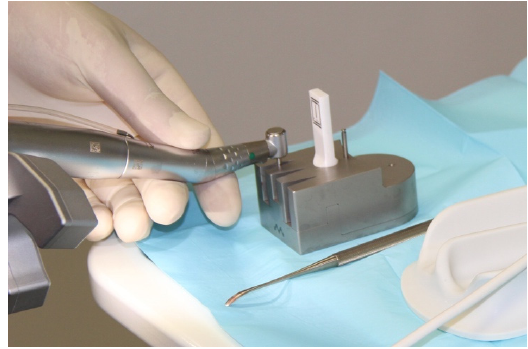
Figure 4. Registering the drill.